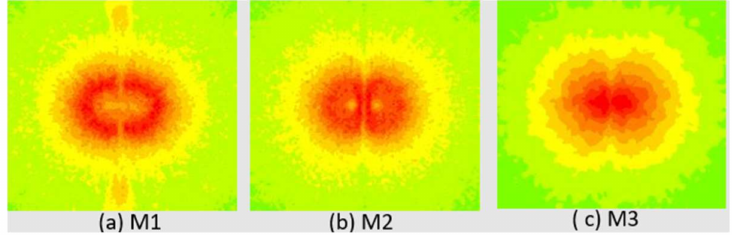
Figure 9. Contour of the surface heat transfer coefficient at the different models. ( a ) S = 1 and H = 1 ( b ) S = 1 and H = 6 ( c ) S = 1 and H =